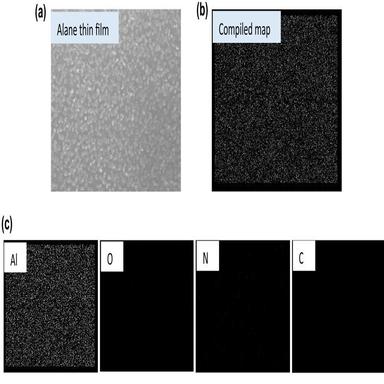
SEM-EDX analysis of an (a) AlH3 thin film surface; (b) the compiled EDX elemental map; and (c) the individual EDX spectra for each precursor element, specifically aluminium (Al), oxygen (O), nitrogen (N), and carbon (C). The spectra illustrate the significant presence of Al, indicated by high count rates, compared to the relatively lower counts for O, N, and C. This suggests that Al is the dominant component in the thin film composition.